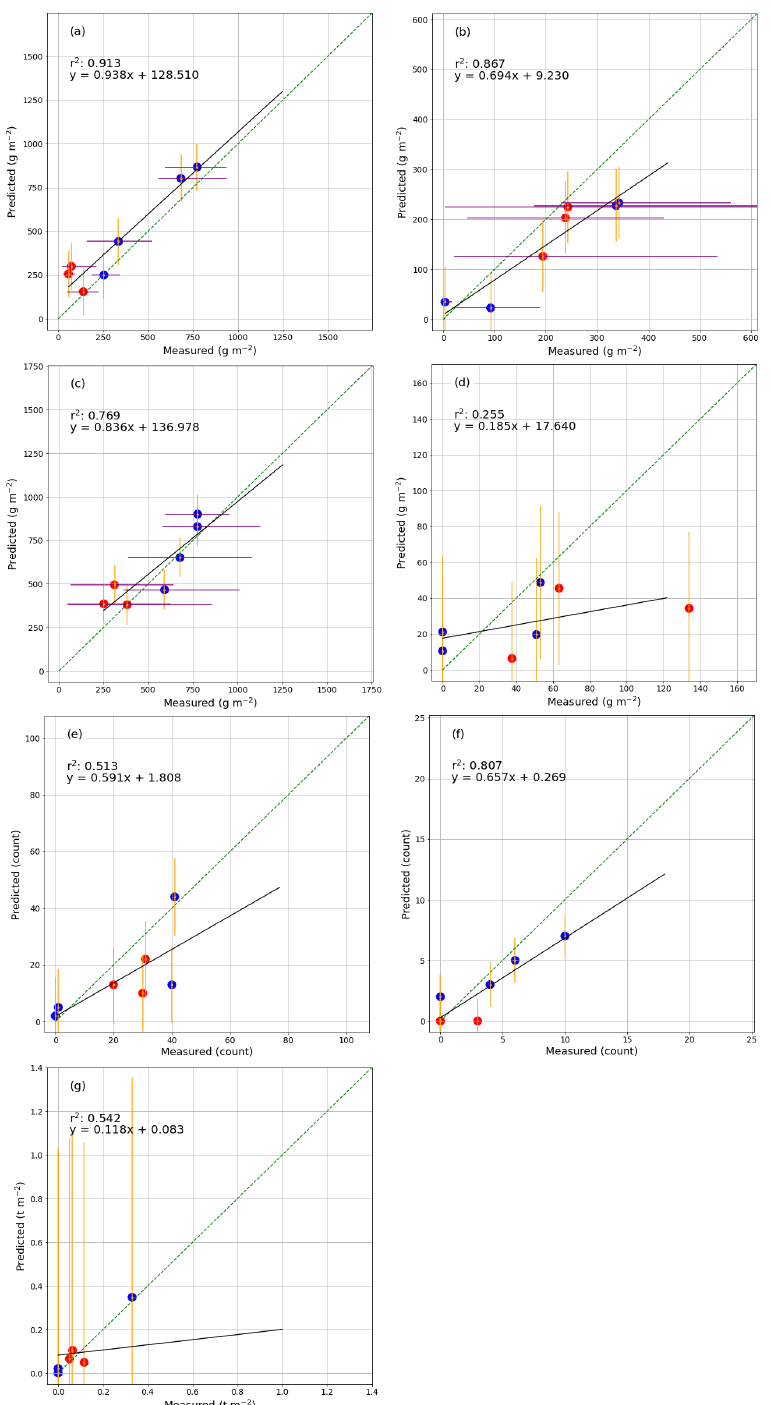
Figure 8. Predicted AGB compared to actual measured AGB values for ( a ) grass, ( b ) litter, ( c ) total fine fuel, ( d ) coarse, ( e ) shrubs, ( f ) trees and ( g ) heavy. Plots in Botswana are shown in red and Niassa in blue. In all plots, orange error bars show the extent of the RMSE error of the model in each fuel class. In some classes where data were collected at multiple locations and then averaged (grass, litter and, consequently, total fine fuel), purple horizontal lines indicate the range of values measured within individual plots, and the points then indicate the